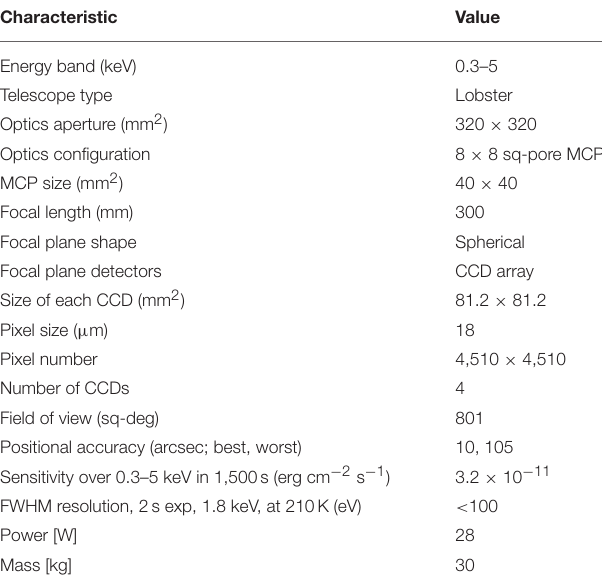
TABLE 3 | WFXT module (1 of 8)